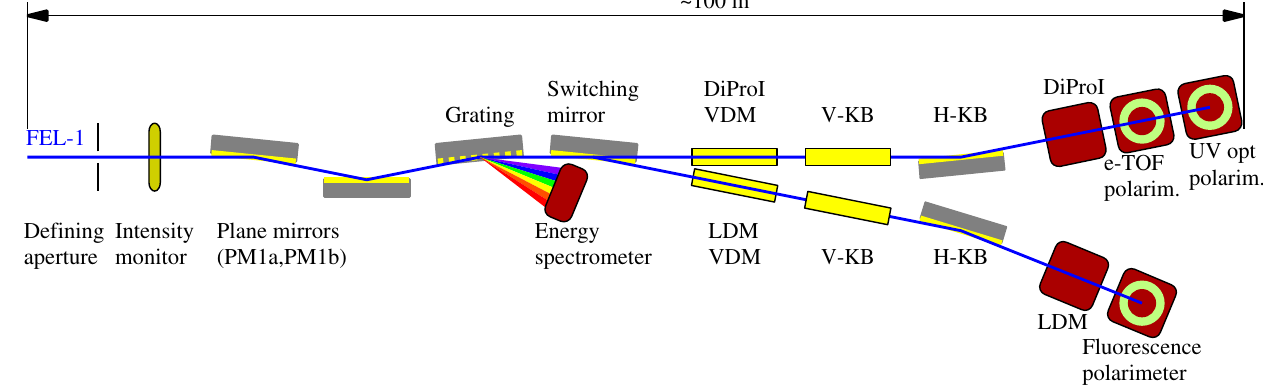
FIG. 2. Schematic layout of the PADReS systems with the three installed polarimeters: a VUV optical polarimeter and an electron time-of-flight (e-TOF) polarimeter have been installed in the DiProI beam line, and a fluorescence polarimeter has been installed in the LDM beam